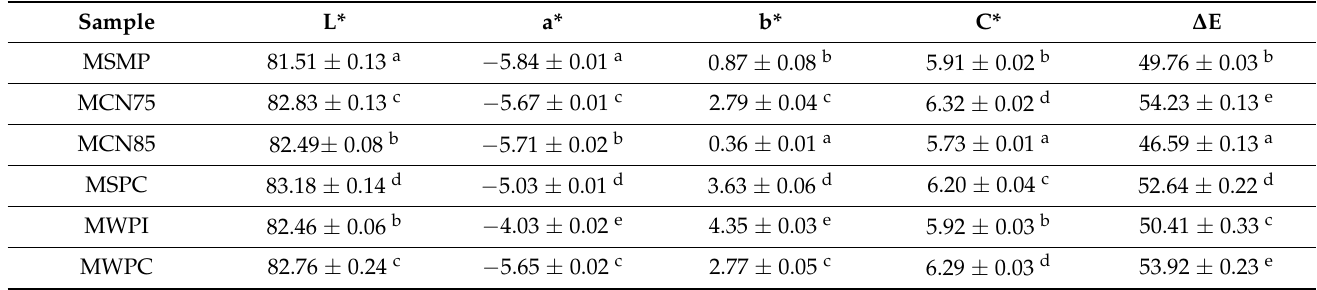
Table 5. Color parameters of non-fermented milks enriched with protein